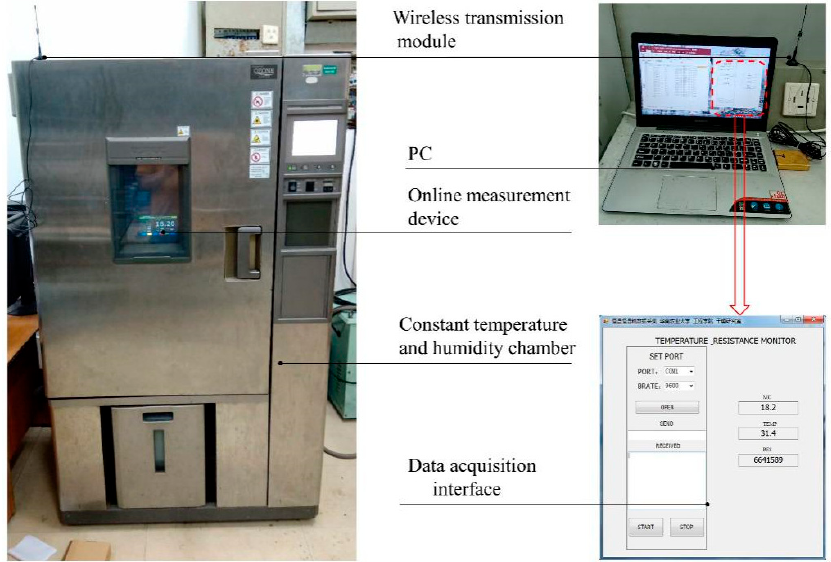
Figure 13. Experimental apparatus for verifying the accuracy of the device in lab tests.